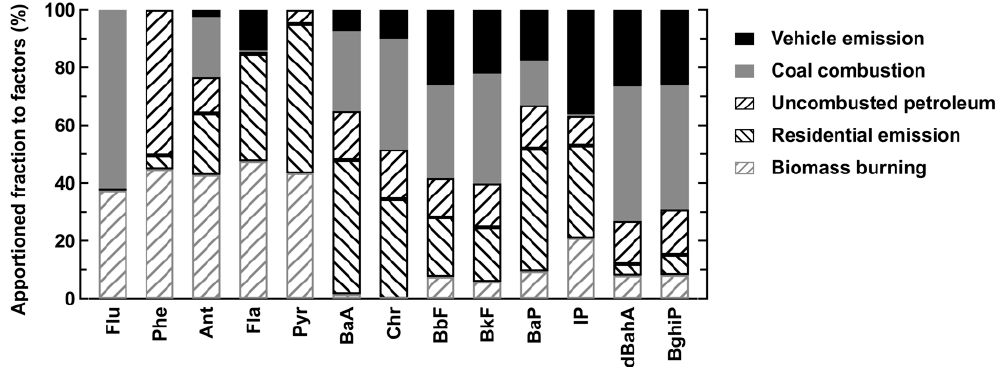
Figure 6. Factor profiles obtained by positive matrix factorization (PMF) analysis from data of 13 PAHs species in PM 10 of Xi’an.